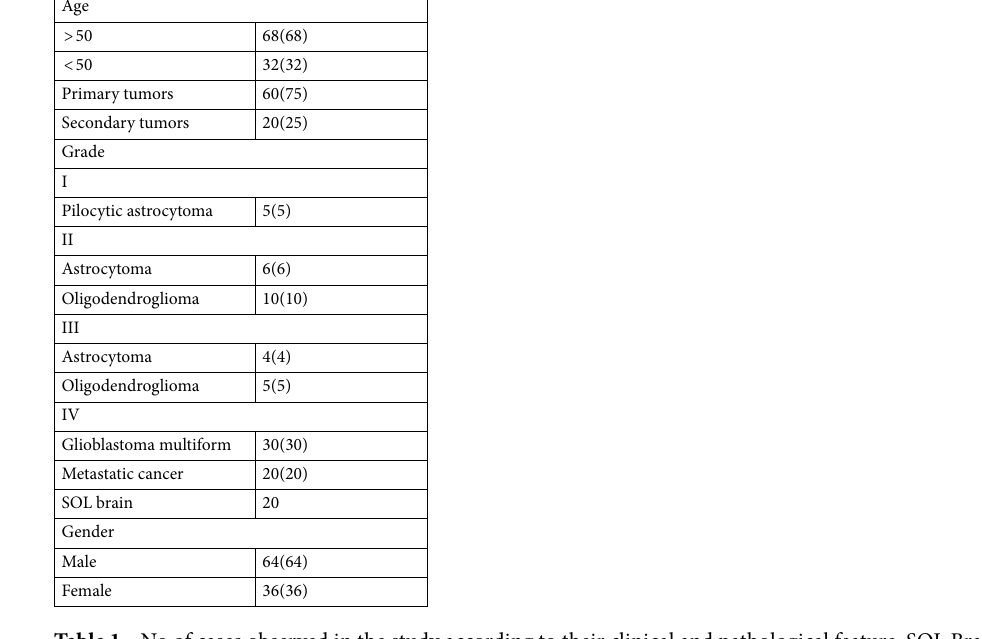
Table 1. No of cases observed in the study according to their clinical and pathological feature. SOL Brain.